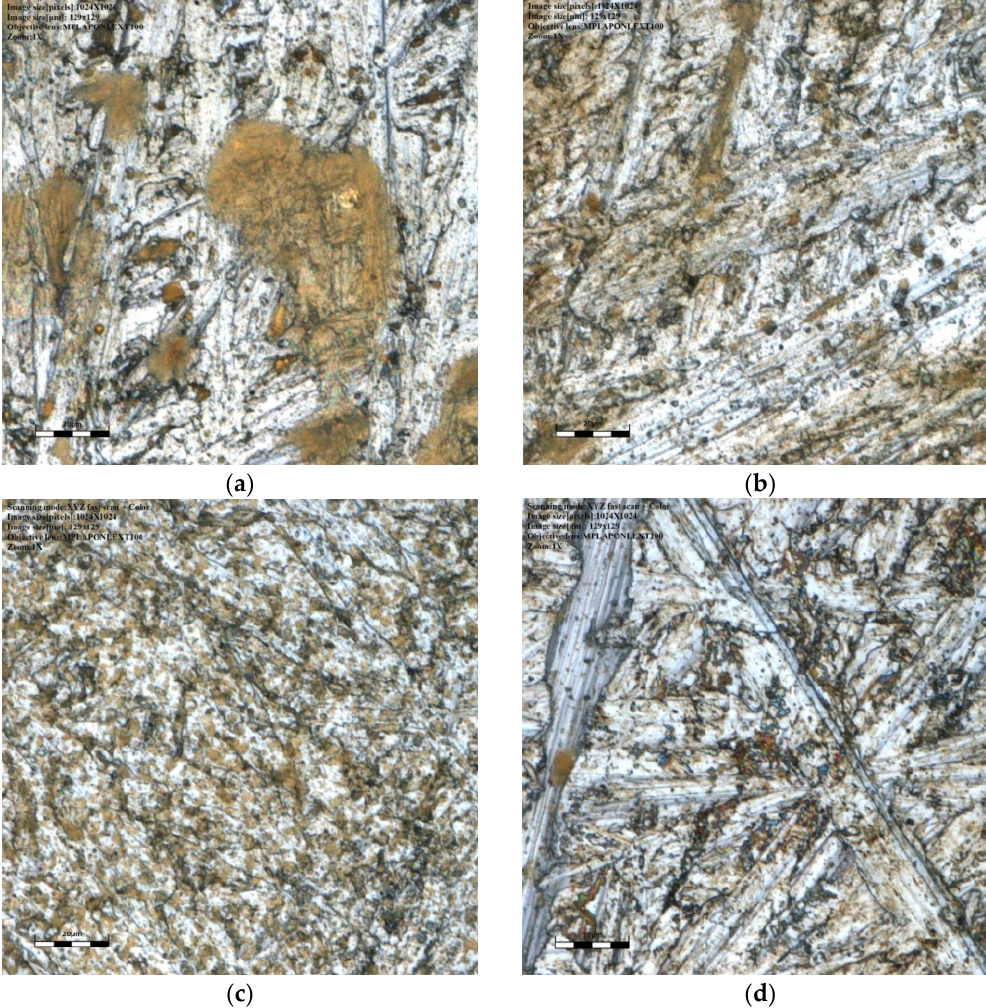
Figure 5. Micrographs of steel samples with zirconium oxide coatings deposited from the solution: 0.2 g /L Zr (IV) + 0.15 g/L W (VI) ( a ) and with additions of Mo (VI) of 0.05 g/L ( b ), 0.1 g/L ( c ), and 0.15 g/L ( d ). Size pixels 1024 × 1024; size µm 129 ×